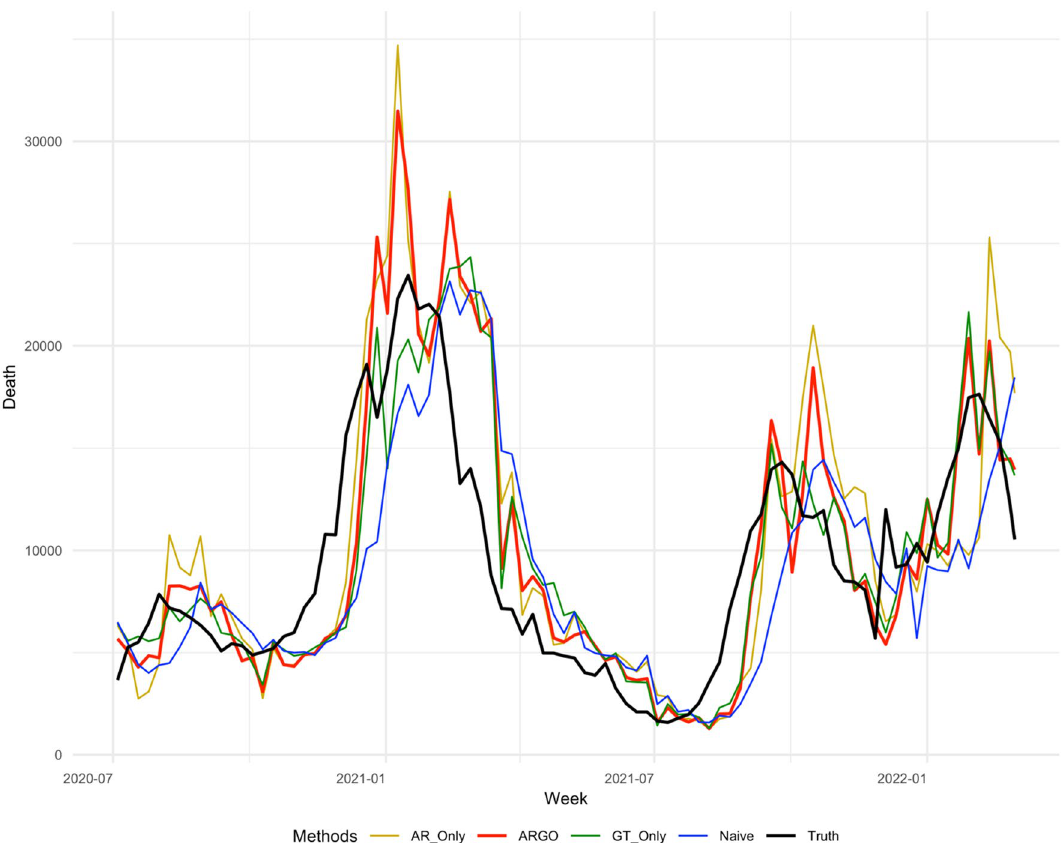
Figure 6. 4 weeks ahead national level COVID-19 weekly incremental death predictions’ comparisons weekly from 2020-07-04 to 2022-03-05. The method included are AR-Only (gold), ARGO (thick red), GT-Only (Green), Naive (blue), truth (thick black).